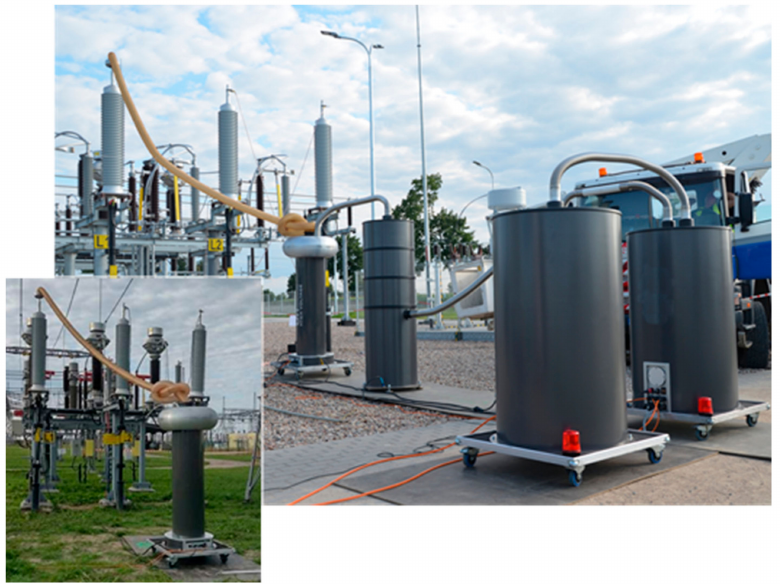
Figure 7. Test setup with the DAC system connected to the 132 kV cable phase being tested at the near end and an additional PD detector at the far end of the same cable phase.